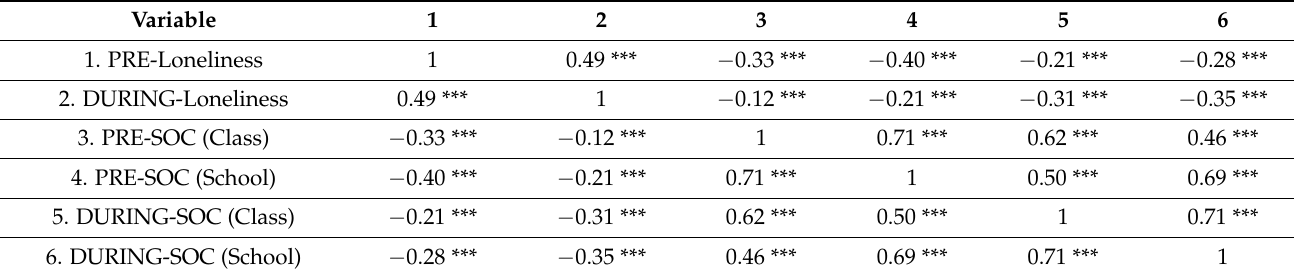
Table 4. Partial correlation of SOC and Loneliness (controlled for